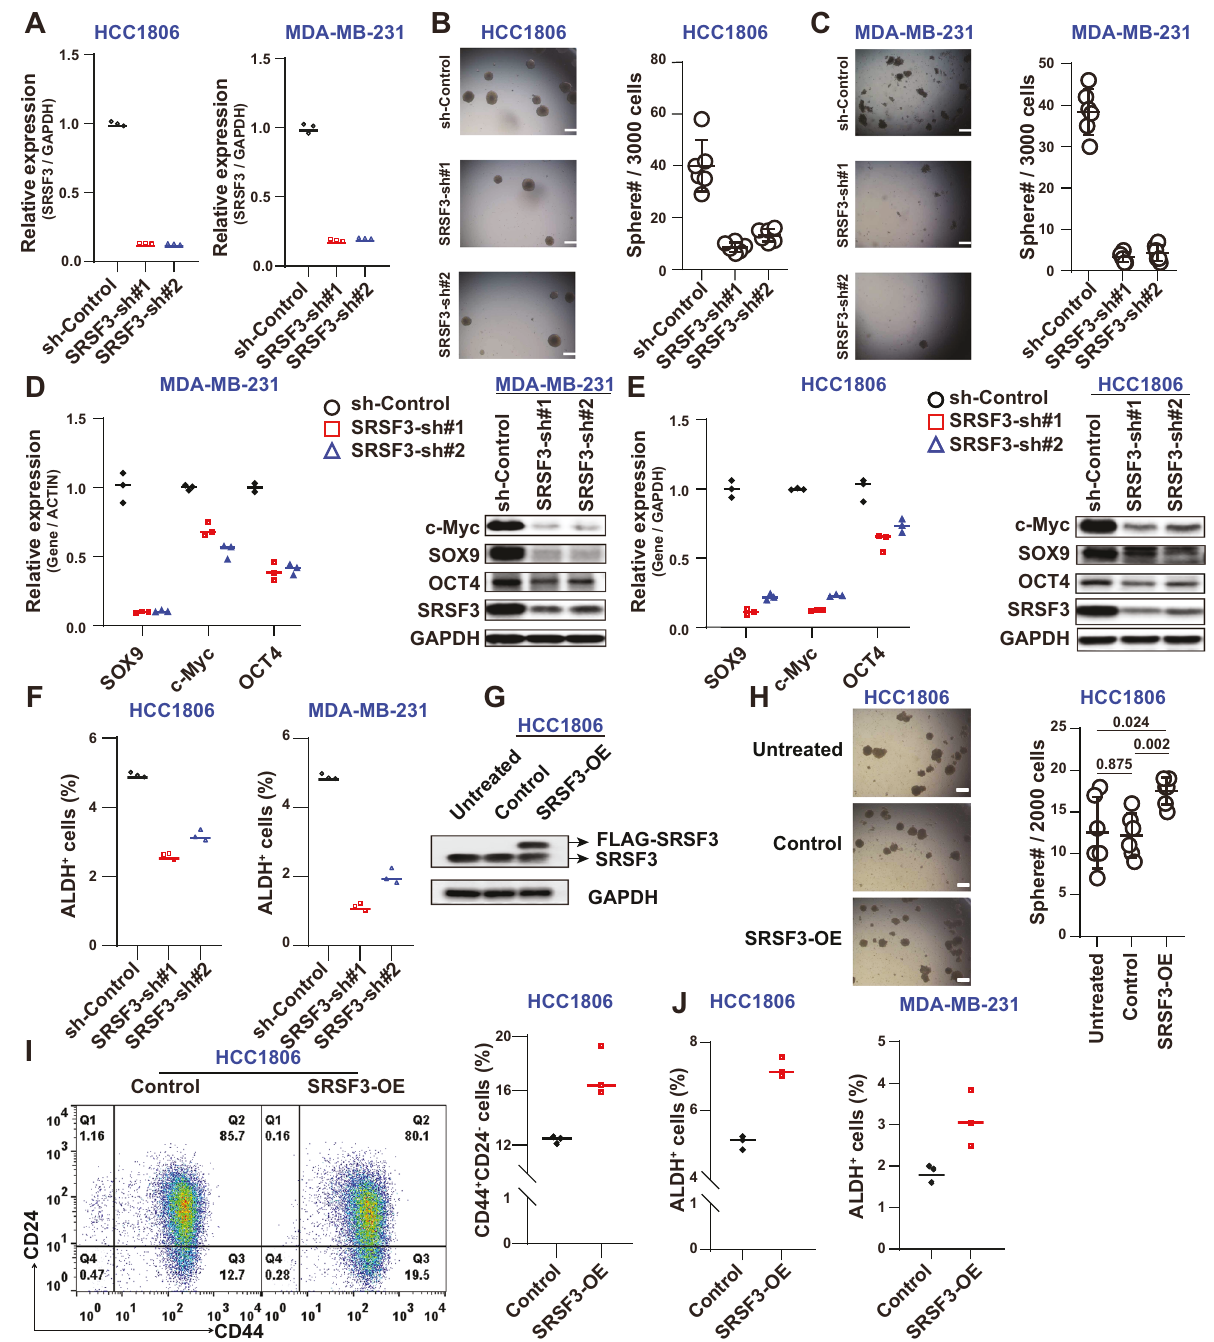
Fig. 3 SRSF3 maintains stemness of BCSCs. A qPCR analysis of SRSF3 KD ef fi ciency in HCC1806 and MDA-MB-231 cells. B , C Comparison of number of tumorspheres in MDA-MB-231 and HCC1806 cells upon SRSF3 KD. D , E Examination of stemness marker (SOX9, c-Myc, and OCT4) at RNA and protein levels upon SRSF3 KD in MDA-MB-231 and HCC1806 cells. F ALDH analysis upon SRSF3 KD in HCC1806 and MDA-MB-231 cells. G Western blotting analysis of SRSF3 protein levels in HCC1806 cells. H Tumorsphere assay upon SRSF3 OE. The unpaired t -test was used to compare the number of sphere among groups. I Flow cytometry analysis of ratios of CD44 + /CD24 − /low population after SRSF3 OE. J ALDH analysis following SRSF3 OE in HCC1806 and MDA-MB-231 cells. Data are means ± of the V2 isoform and thereafter increase the abundance of levels of SRSF3 (Fig. 5C and WB), indicating that TDP43 may be TDP43 V1 mRNA. To verify this hypothesis, the TDP43 V2 mRNA a downstream factor of SRSF3. level was detected with speci fi c primers upon SRSF3 KD in the For the two main isoforms of TDP43 (V1 and V2), AS occurs in MDA-MB-231 cells (Fig. 5D). Using an NMD inhibitor, cyclohex- the 3 ’ -untranslated region (3 ’ -UTR), and the unstable V2 imide, the degradation of the TDP43 V2 isoform was isoform undergoes NMD (Fig. 5D) [44]. Based on the binding signi fi cantly inhibited, con fi rming the existence of NMD of of SRSF3 to TDP43 pre-mRNA (Fig. 5A), we hypothesized that the TDP43 V2 isoform in breast cancer cells (Fig. 5E). Moreover, the SRSF3 protein may bind to the TDP43 3 ’ -UTR to inhibit NMD